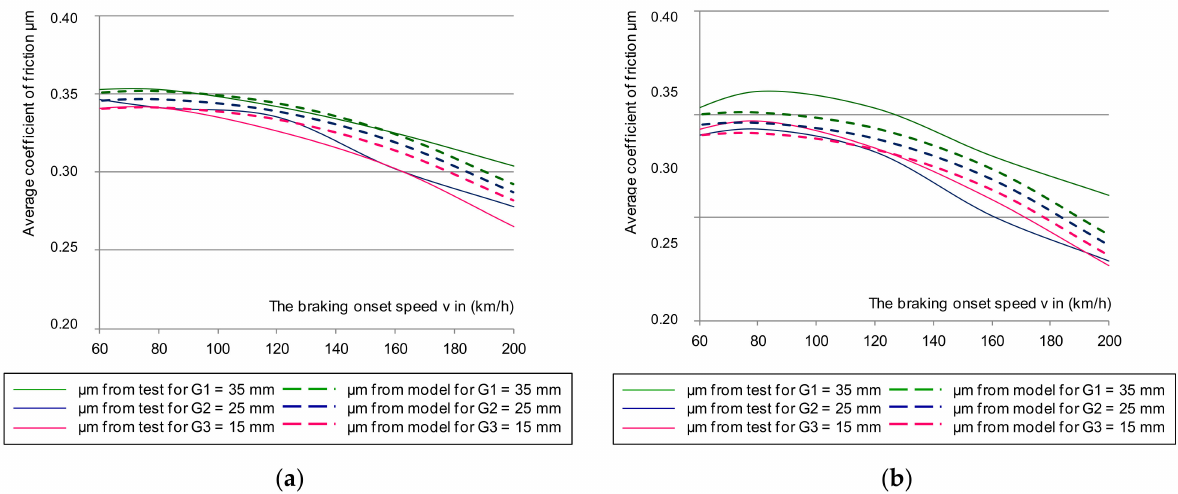
Figure 16. The changes of µ m from the tests with multiple regression model during braking on a new disc type 590 × 110 z: ( a ) N = 25 kN and M = 5.7 t, ( b ) N = 36 kN and M = 5.7